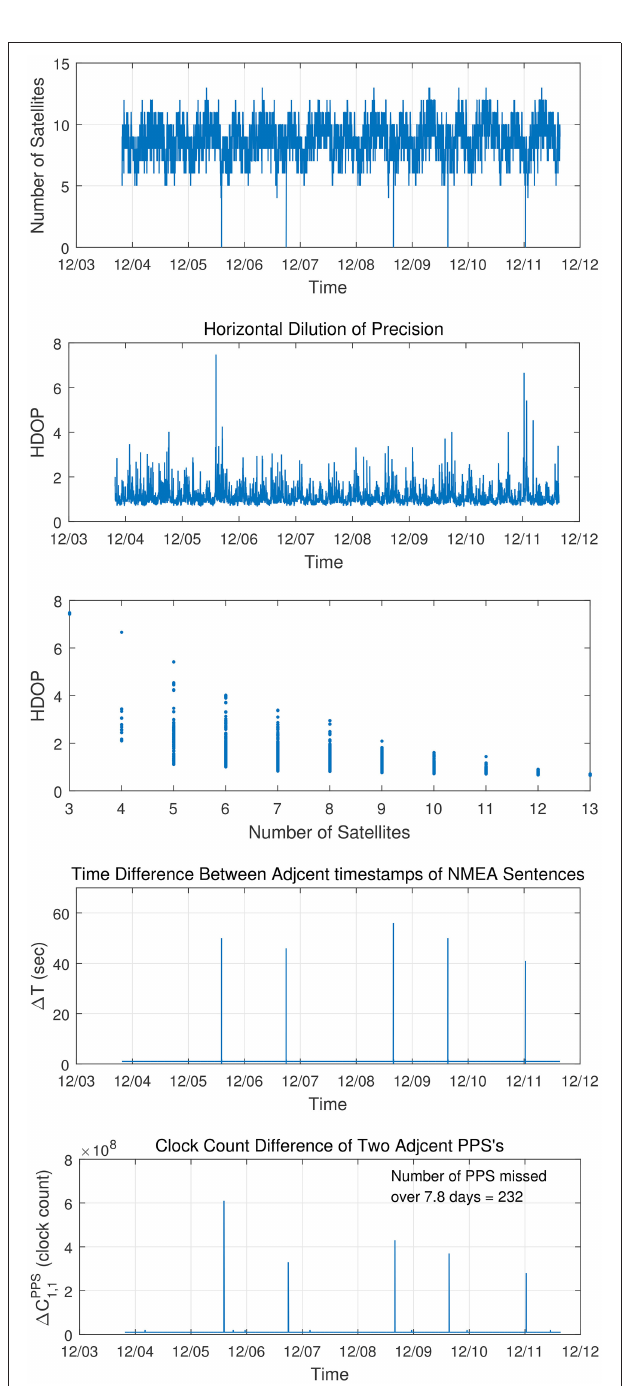
FIGURE 9 | Long-term operational reliability of GPS